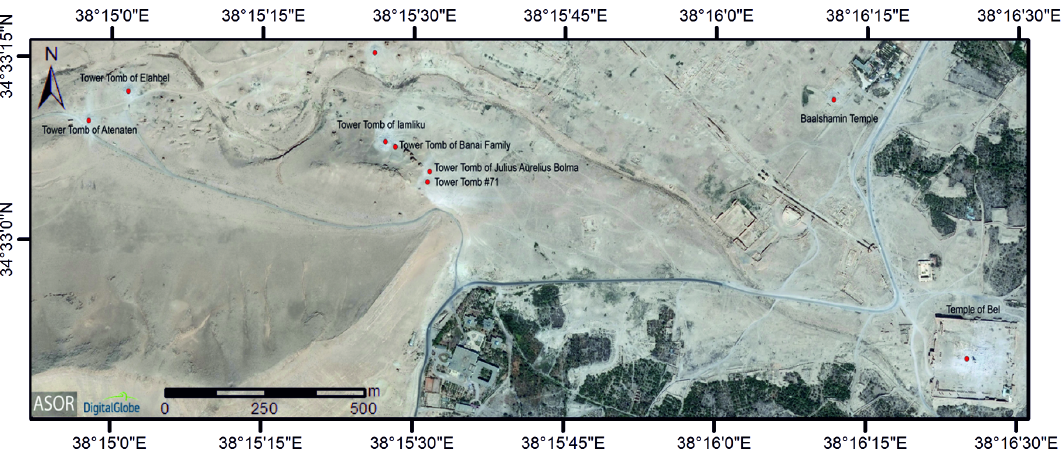
Figure 9. Report from [29] showing destroyed CH sites in Palmyra. This map was used as validation for the detected damaged areas ( c (cid:13) ASOR